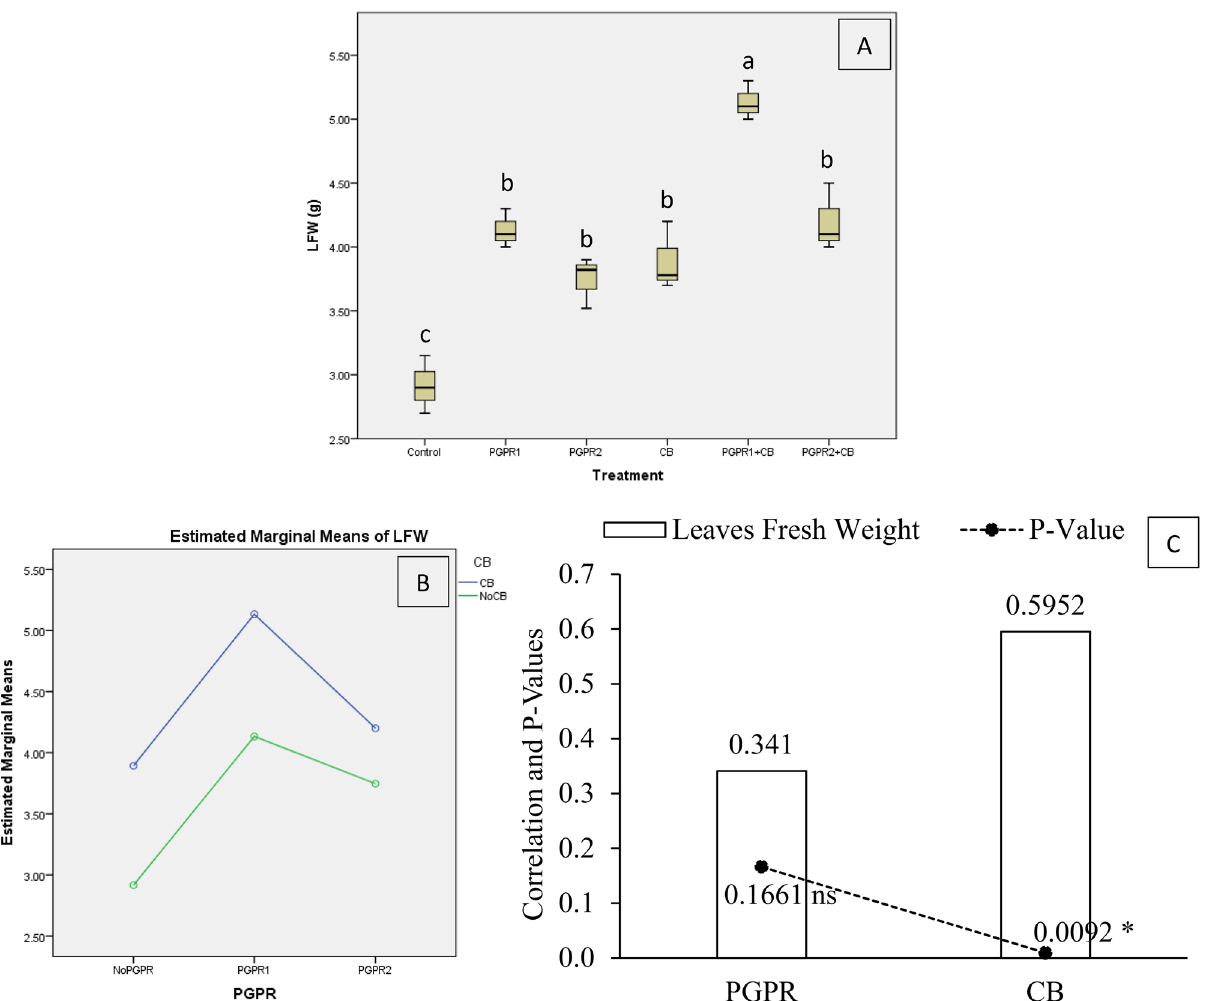
Figure 9. Effect of treatments on mint plants leaves fresh weight (LFW). Values are the average of three replicates ( A ). Different letters showed significant differences (Tukey’s test; p ≤ 0.05). Interaction graph of PGPR and CB for LFW ( B ). Correlation graph of PGPR and CB for LFW ( C